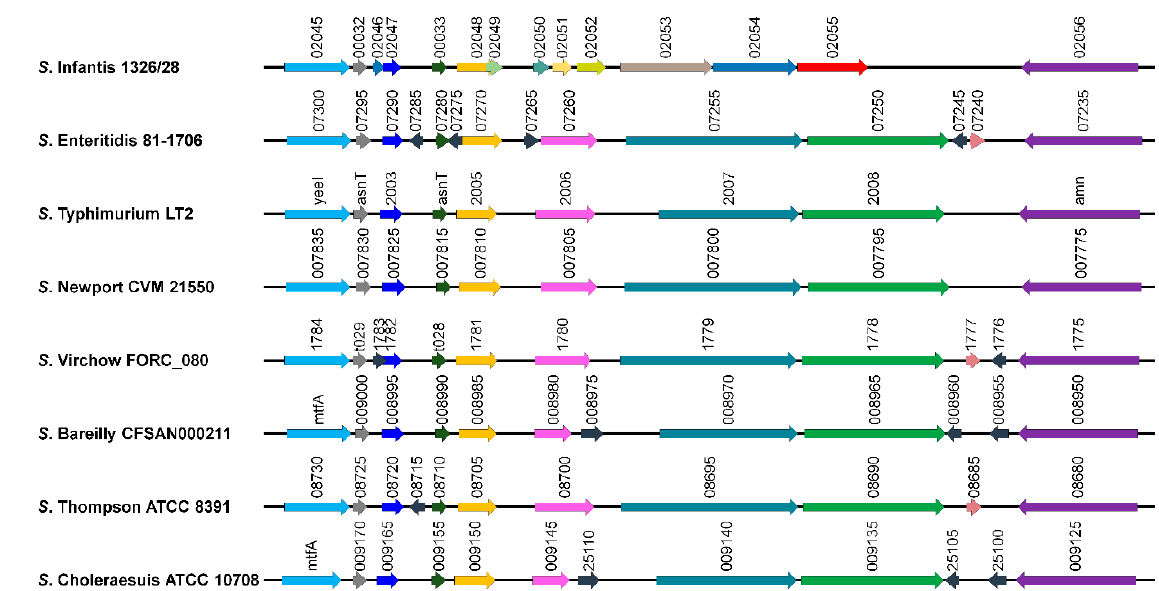
Figure 2. Comparison of usg loci among eight serovars (Infantis, Virchow, Bareilly, Thompson, Choleraesuis, Enteritidis, Typhimurium, and Newport). A consistent color coding indicates orthologous genes. The locus of the usg gene is high- lighted in red.